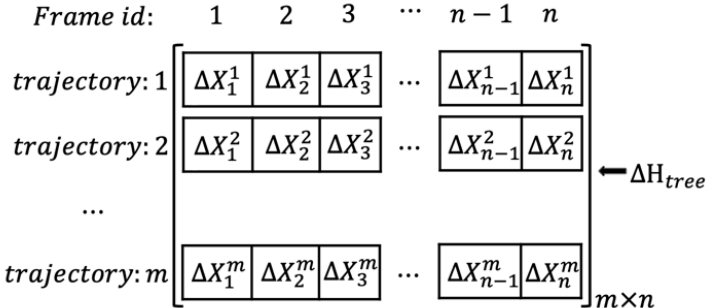
Figure 5. Proposed multiple trajectory hypotheses model ∆ H tree . ∆ X m n denotes the relative coordi- nates ( ∆ x , ∆ y ) of the n th point in the m th trajectory.